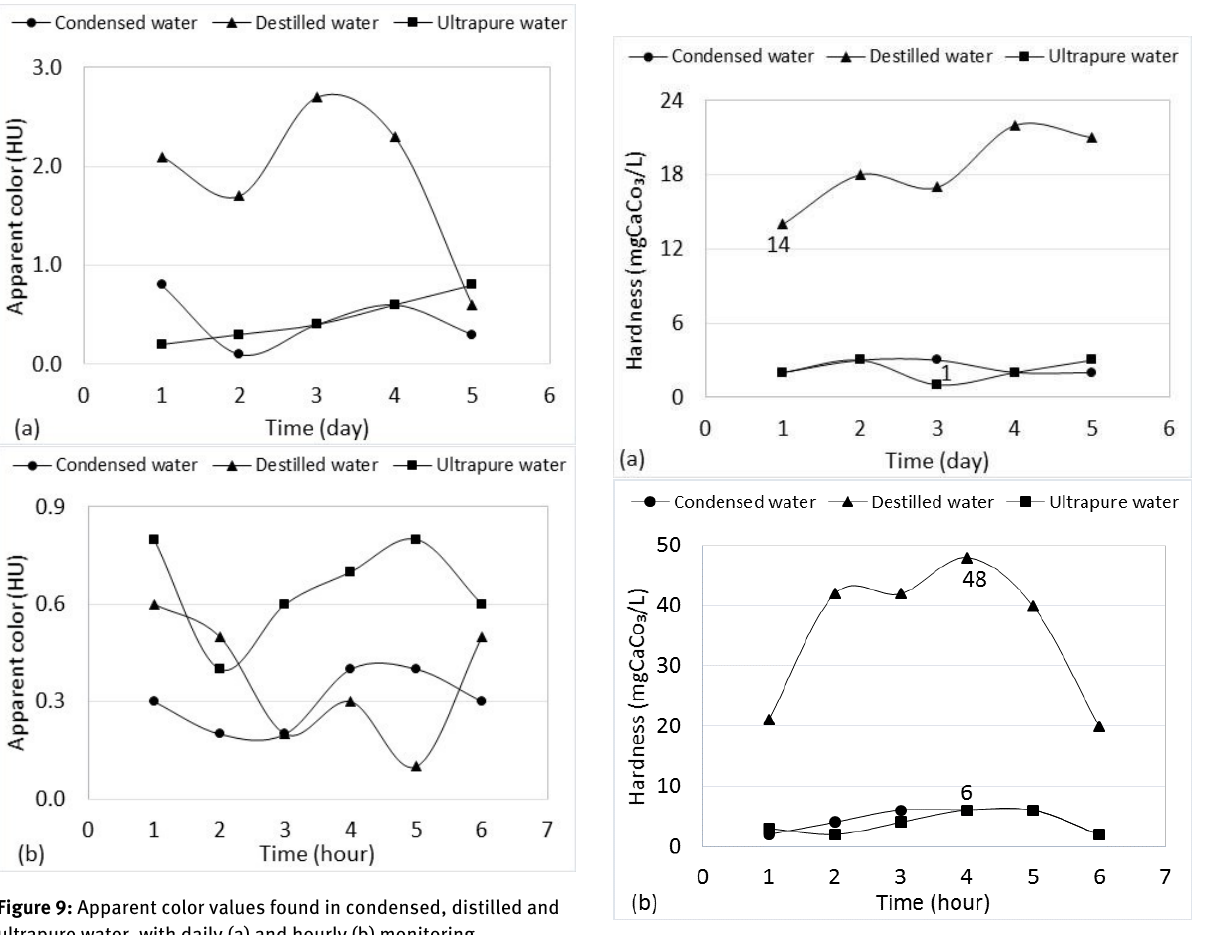
Figure 10: Hardness values found in condensed, distilled and ultra- pure waters, with daily (a) and hourly (b)